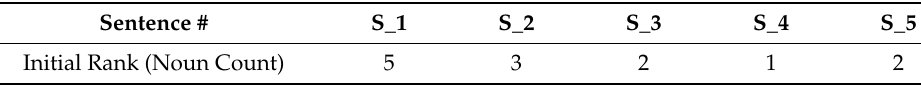
Table 2. Modified Text Rank: Initial node score.